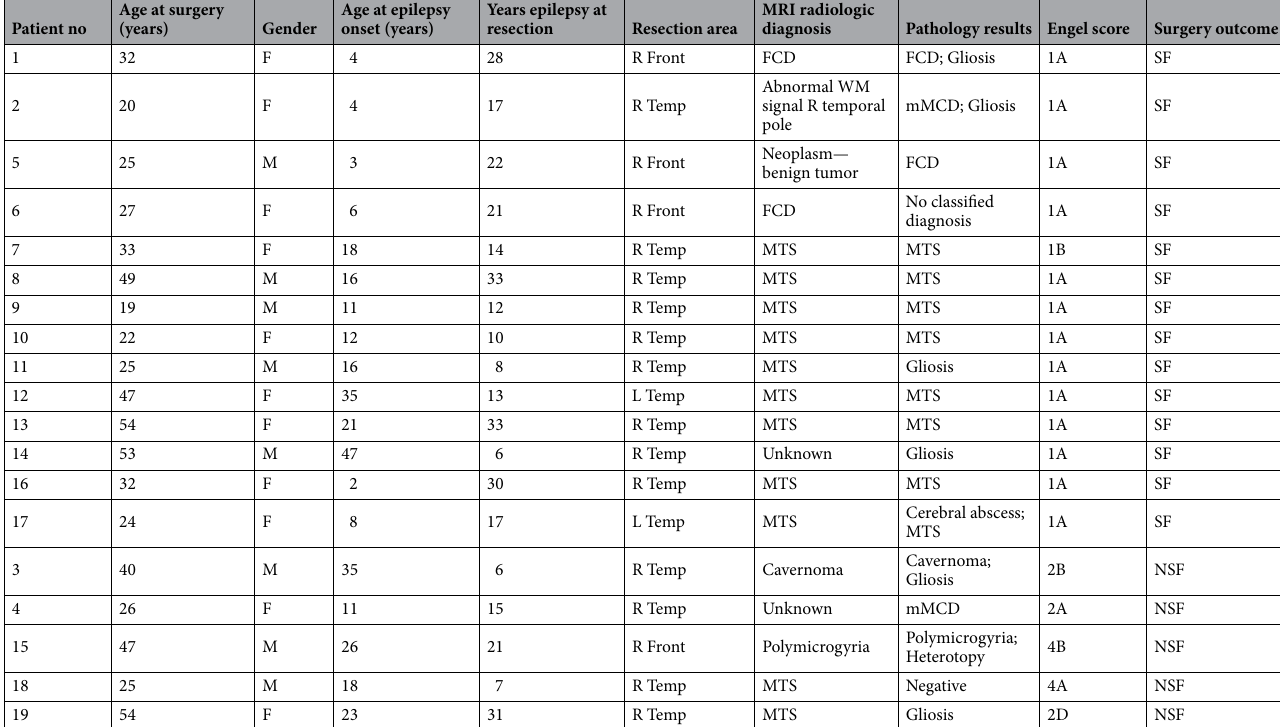
Table 1. Patient characteristics of the seizure-free (upper part) and not seizure-free patients (lower part). F = female, M = male, R = right, L = left, Front = frontal, Temp = temporal, FCD = focal cortical